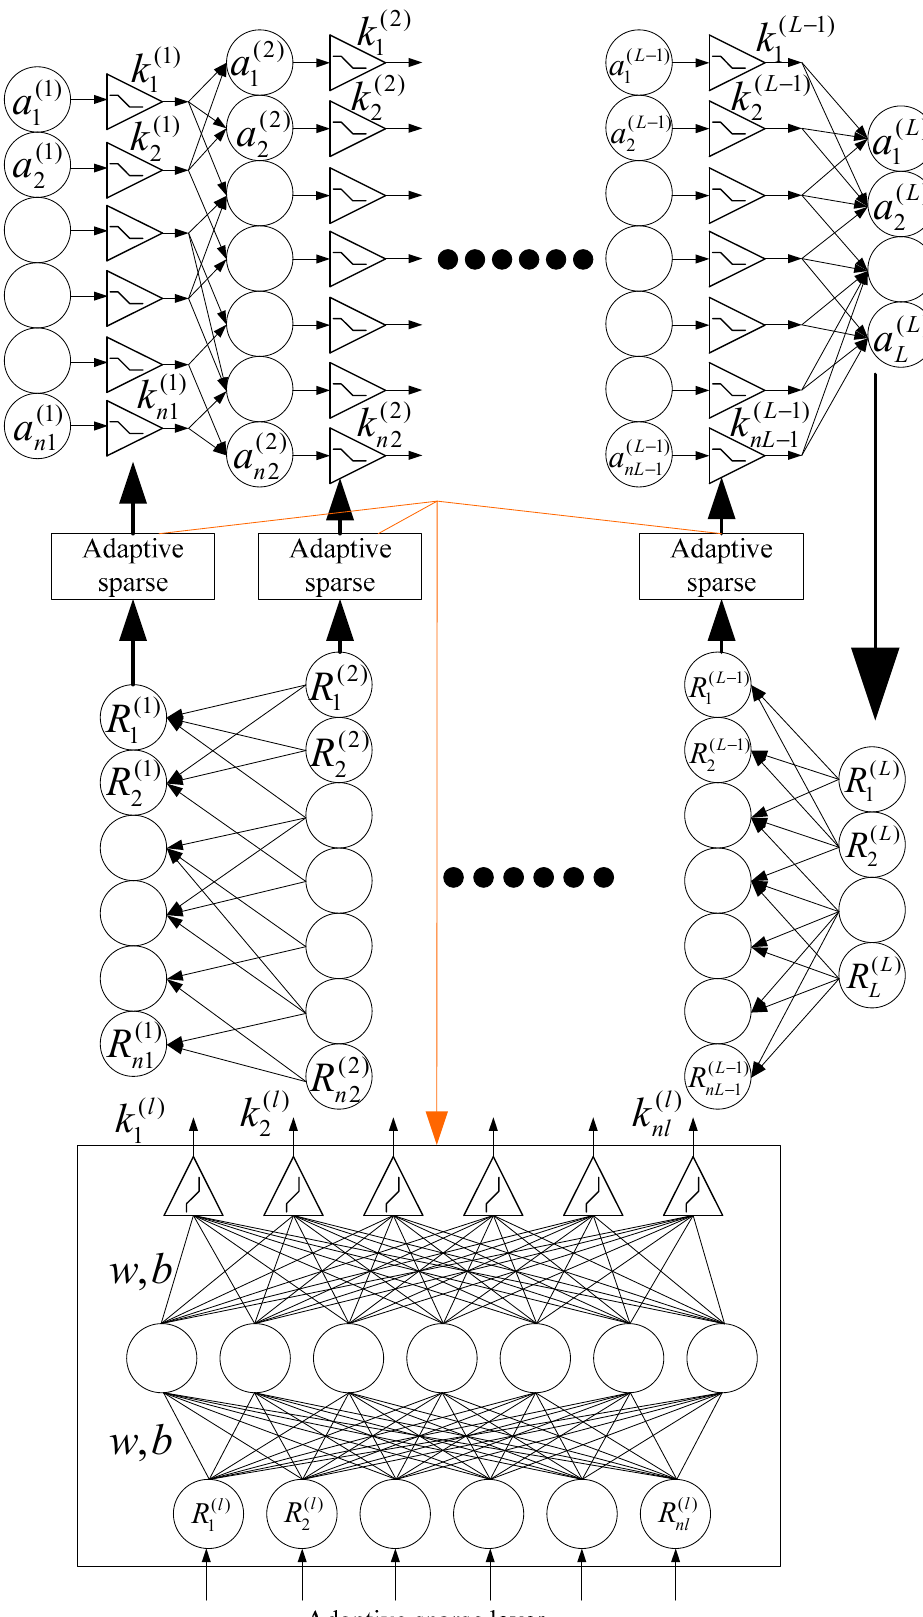
Figure 3. The interpretable adaptive sparse deep neural networks.